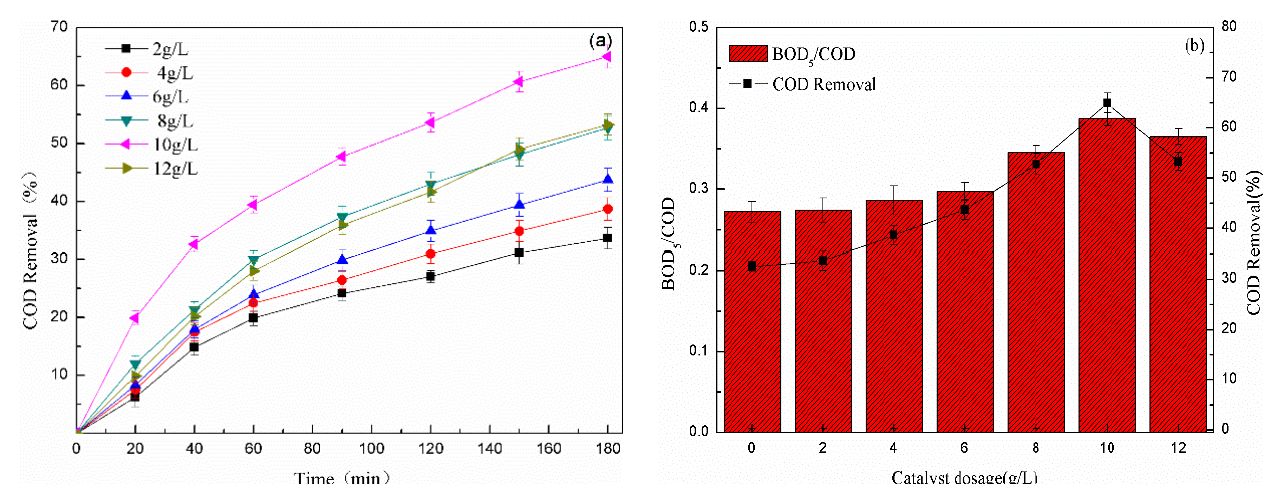
Figure 5. Effect of catalyst dosage on ( a ) COD removal and ( b ) BOD 5 /COD of pharmaceutical wastewater (initial pH = 2.0, hydrogen peroxide concentration = 0.5 mol/L, light distance = 20 cm).